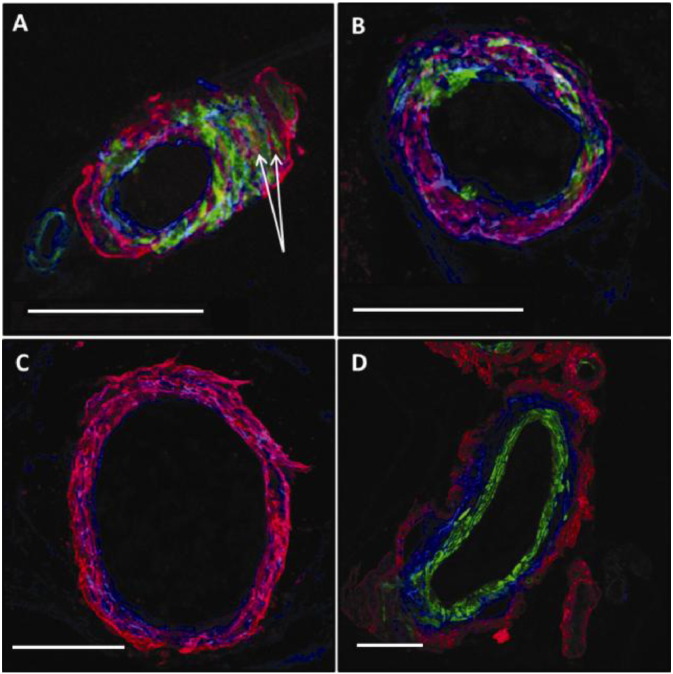
The spectrum of different patterns of deposition of Aβ in CAA. Maximal projection overlaid confocal images of a human leptomeningeal artery from severe CAA brain: A) the basement membrane (collagen IV, blue) of the tunica media is interposed between the smooth muscle cells (green immunolabelling). Aβ (red, arrows) is observed within the basement membranes of tunica media, with blue immunolabelling for collagen IV on both sides; the endothelial BM is free of Aβ; B) co-localization (pink) between the red Aβ and blue Col IV within the BM with the absence of SMA immunolabelling for more of half of the circumference of the arterial wall; C) complete loss of SMA immunolabelling, with Aβ co-localizing with collagen IV in tunica media; D) transverse section through an artery, with Aβ deposited in the adventitia. Blue = Col IV, green = SMA, red = Aβ. Scale bars: 50 μm.